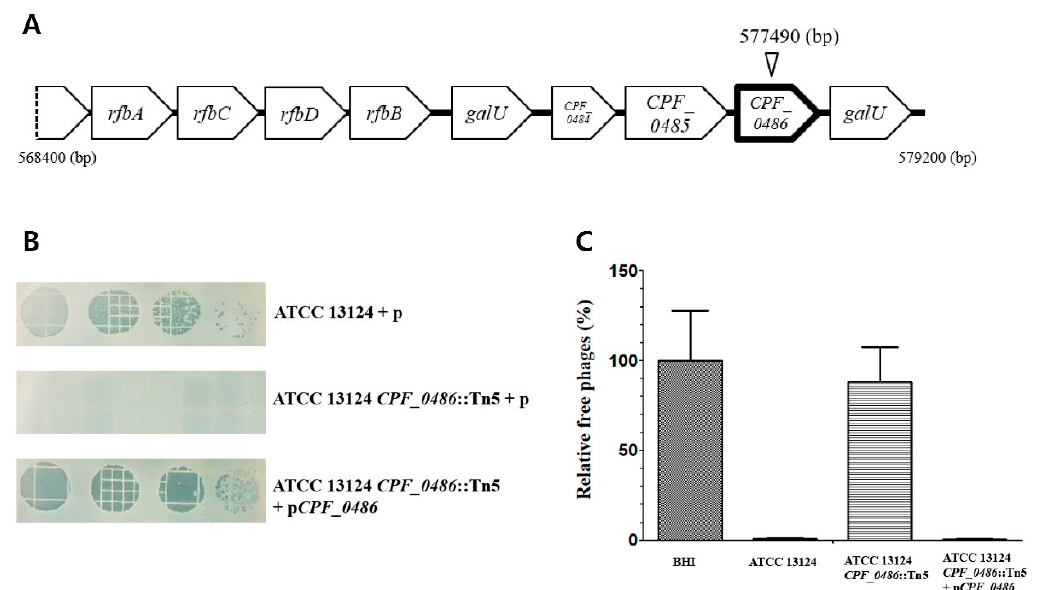
Figure 3. The CPF_0486 gene was involved in CPS1 resistance. ( A ) Gene order surrounding the CPF_0486 gene in C. perfringens ATCC 13124. The inverted triangle is the EZ-Tn5 transposon insert site. ( B ) Bacteriophage serial diluted dotting assay with ATCC 13124 plus pJIR750, ATCC 13124 CPF_ 0486 ::Tn5 plus pJIR750, complementary strain. ( C ) CPS1 was not able to attach to the CPF_0486 ::Tn5 mutant. All adsorption assays were performed at 30°C for 40 min. The means and standard deviations from three independent experiments are indicated by error bars.